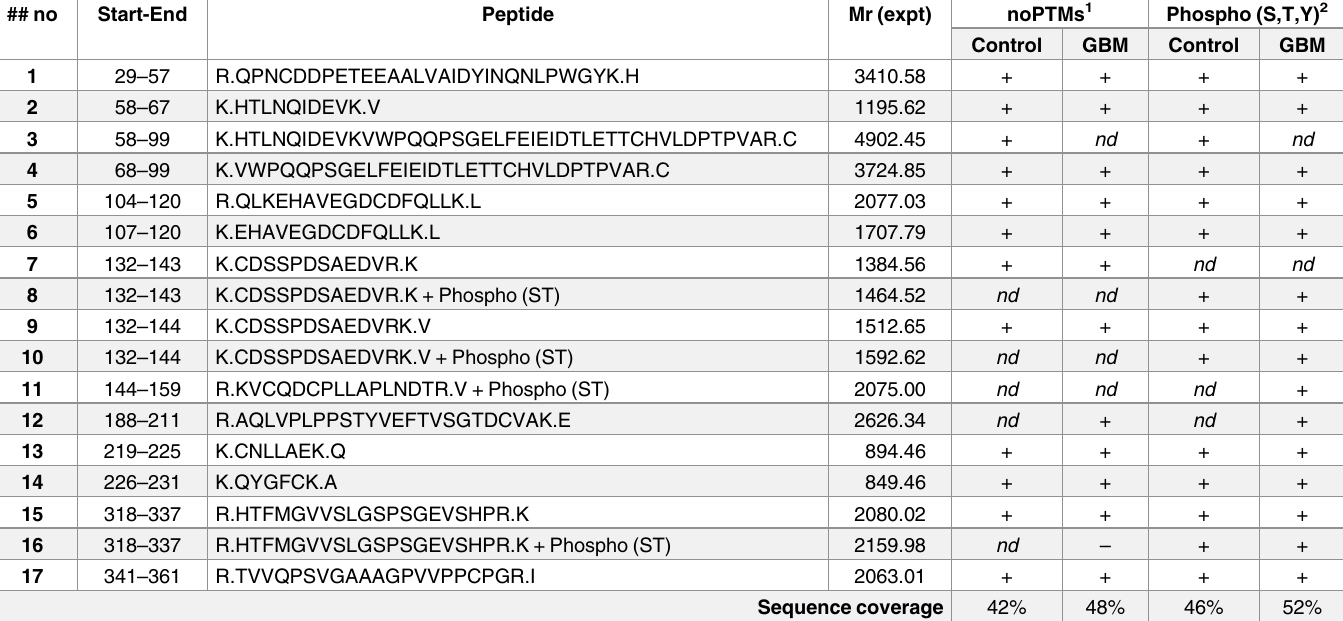
Table 2. Enrichment of plasma Alpha-2-HS-glycoprotein (FETUA_HUMAN, 367 aa) sequence coveragewith peptides assembledfrom MS/MS search for phosphorylated peptides. ##